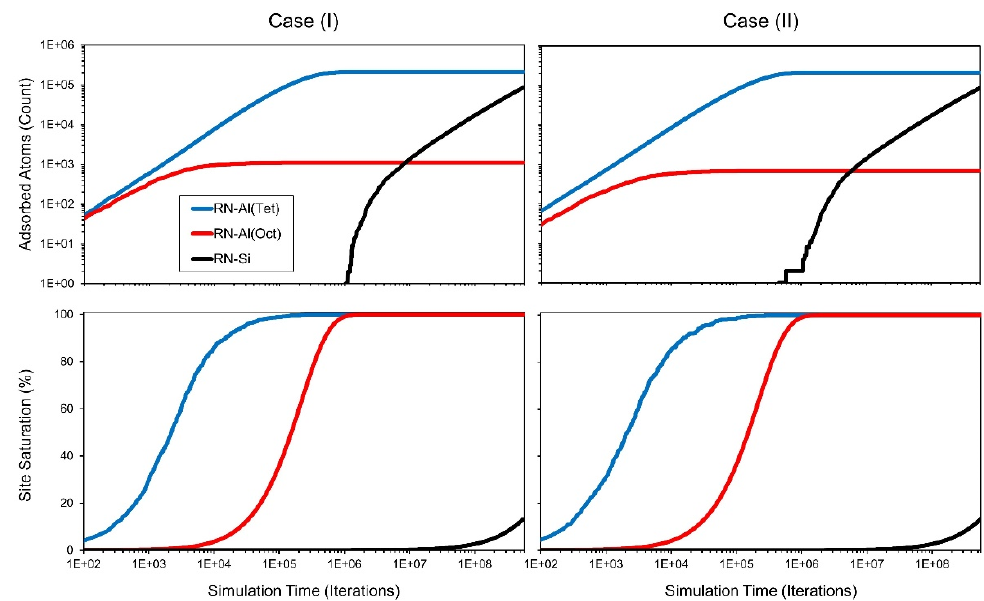
Figure 4. Coordination of the adsorbed atoms for both cases ( I ) and ( II ) with proceeding simulation. Both cases produce a similar distribution of adsorption sites. Case ( II ) has only about 60% of the octahedral sites found in case ( I ). The times for reaching full site saturation for aluminum sites are roughly the same in both cases, and adsorption to silicon starts at full saturation of both other sites. By looking at the site saturation, it is observable that both aluminum sites become fully saturated during the simulation.